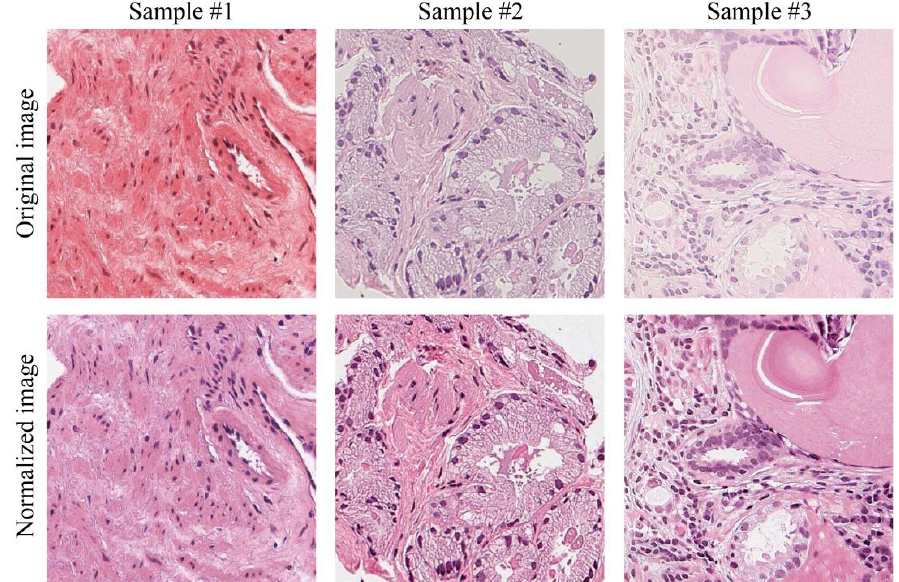
Figure 5. Visual performance of normalization process. In the first row, there are examples of tiles with suboptimal staining: reddish (sample #1), greyish color (sample #2) and weak staining (sample #3). The second row shows the corresponding normalized tiles.